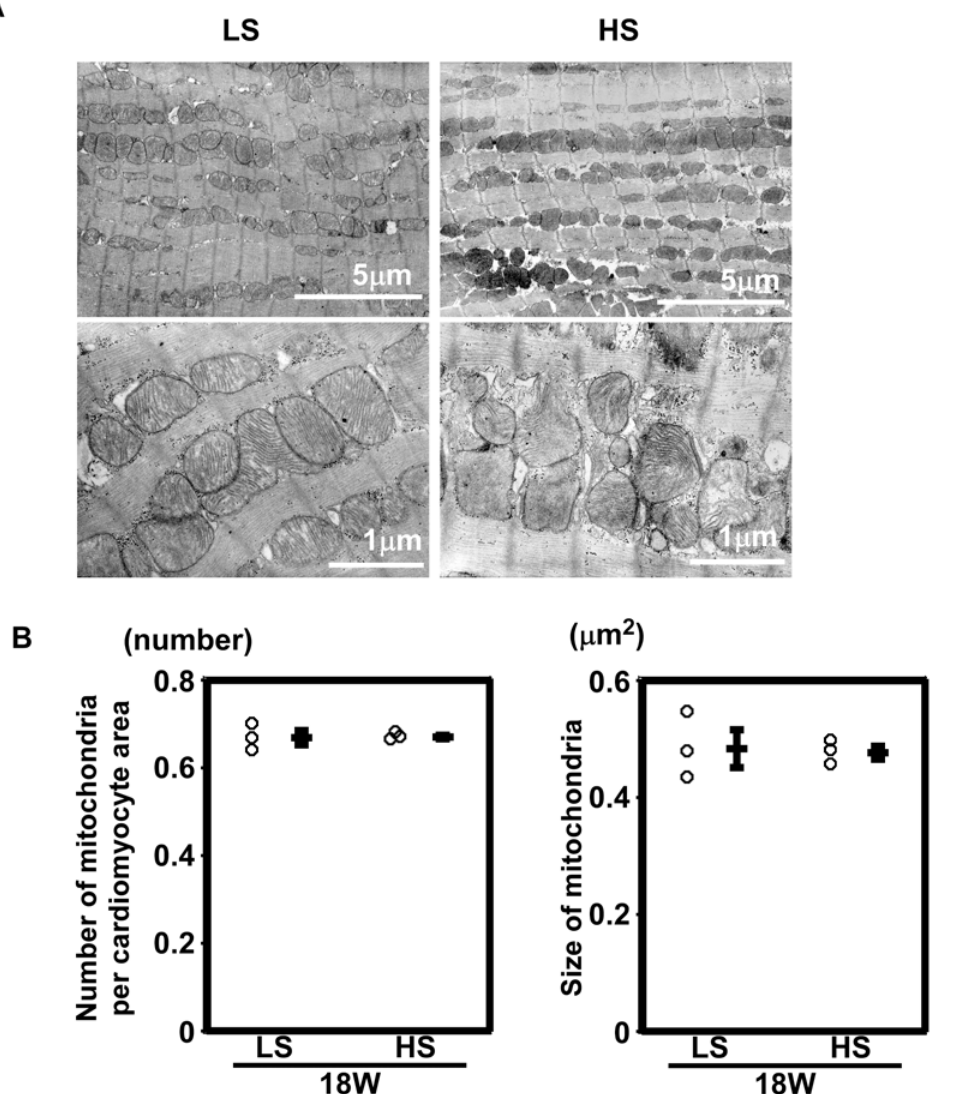
Figure 9. Mitochondrial density and morphology. (A) Low- and high- power electron micrographs from the left ventricles of rats fed an LS diet and an HS diet. (B) The density of mitochondria (number per 100 μ m 2 ) and the size of mitochondria ( μ m 2 ) were not different between LS and HS group. n = 3 in each